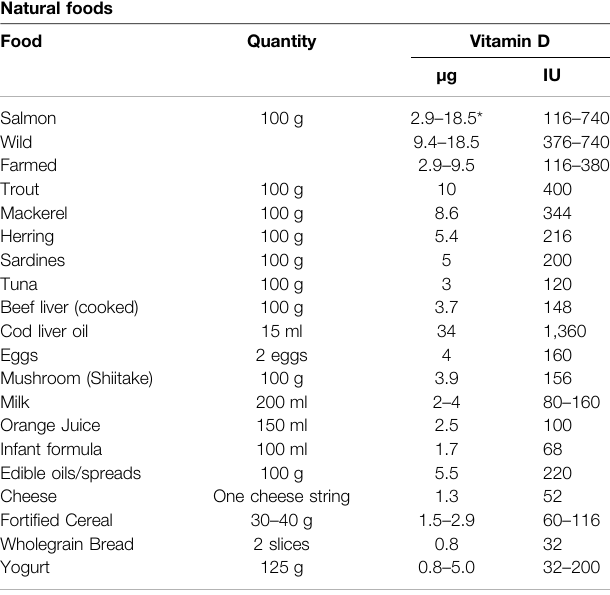
TABLE 1 | Natural dietary and forti fi ed food sources of Vitamin D. Natural foods